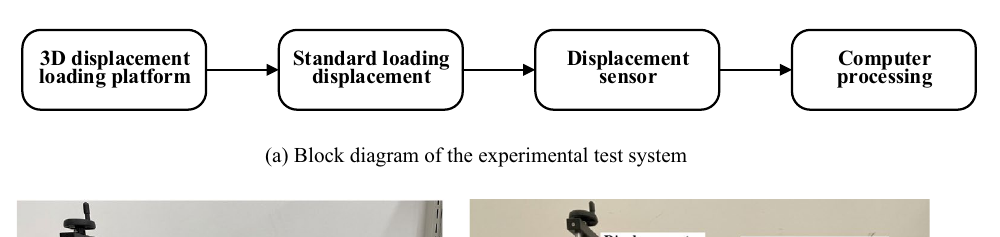
Standard loading displacement